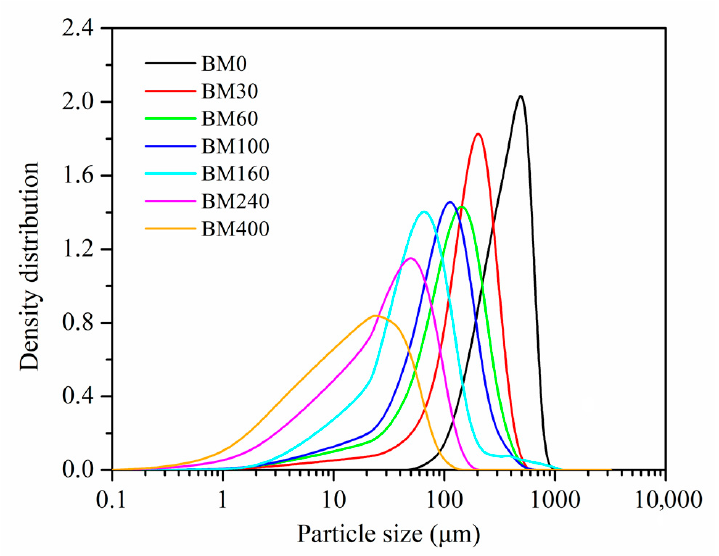
Figure 1. Particle size distribution curves of PIDF samples prepared using different grinding times.